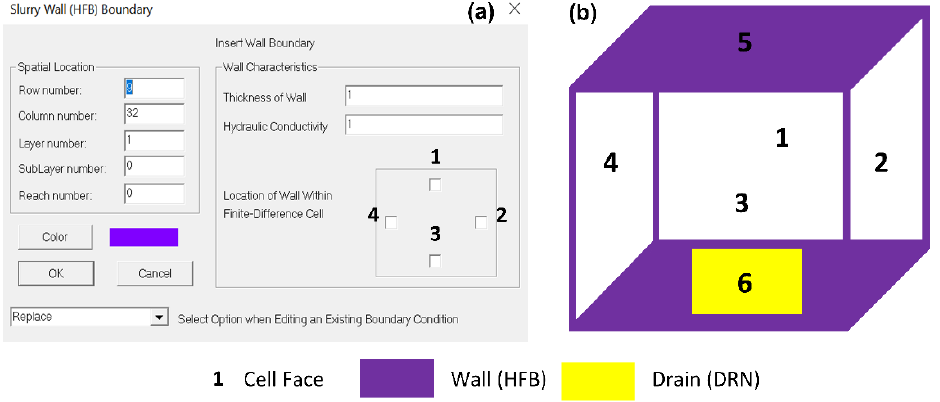
Figure 5. ( a ) Traditional application scheme for HFBs cell; insertion mask taken from Groundwater Vistas 8; ( b ) conceptual model of the adopted approach to model all the UIs.